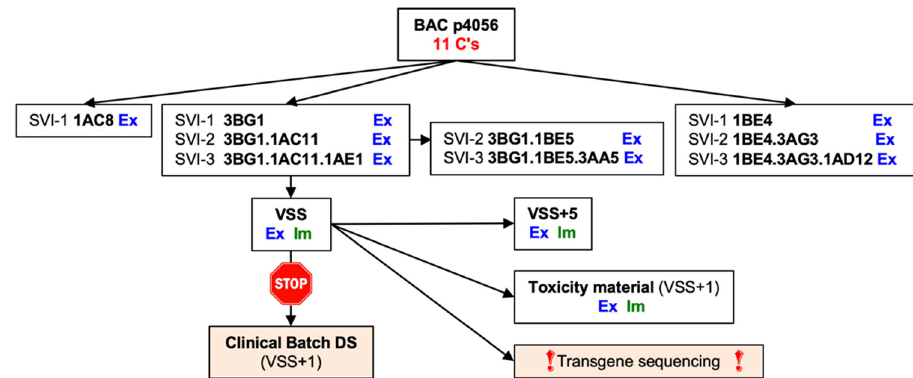
Figure 4. Workflow of the aborted pre-clinical development of the ChAdOx1.tHIVconsv6 vaccine. Numbers in the boxes indicate the clone numbers after SVI-1 (X), SVI-2 (X.X) and SVI-3 (X.X.X). BAC—bacterial artificial chromosome; SVI—single virion infection; Ex—expression of tHIVconsv6 protein with p24 confirmed in infected HeLa cells; Im—murine immunogenicity to 8 defined virus seed stock; VSS+1—VSS passaged one time in the M9.S cells; VSS+5—VSS plus five blind